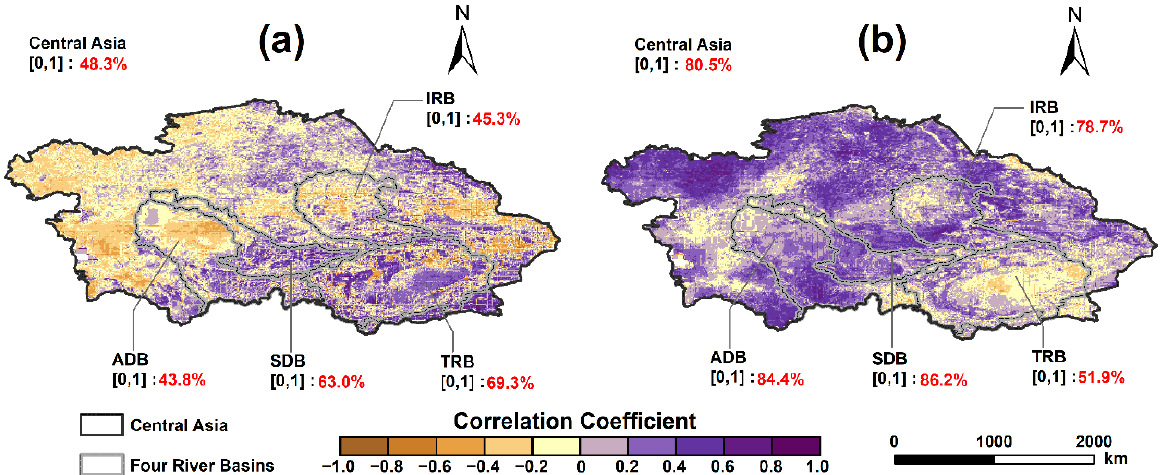
Figure 9. Spatial correlation between climatic factors and NDVI (1982–2017). ( a ) Spatial correlation between temperature and NDVI. ( b ) Spatial correlation coefficient between precipitation and NDVI. Square brackets represent positive correlations. Red text indicates the percentage of areas with positive correlations in the respective regions. ADB, Amu Darya Basin; SDB, Syr Darya Basin; IRB, Ili River Basin and TRB, Tarim River Basin.